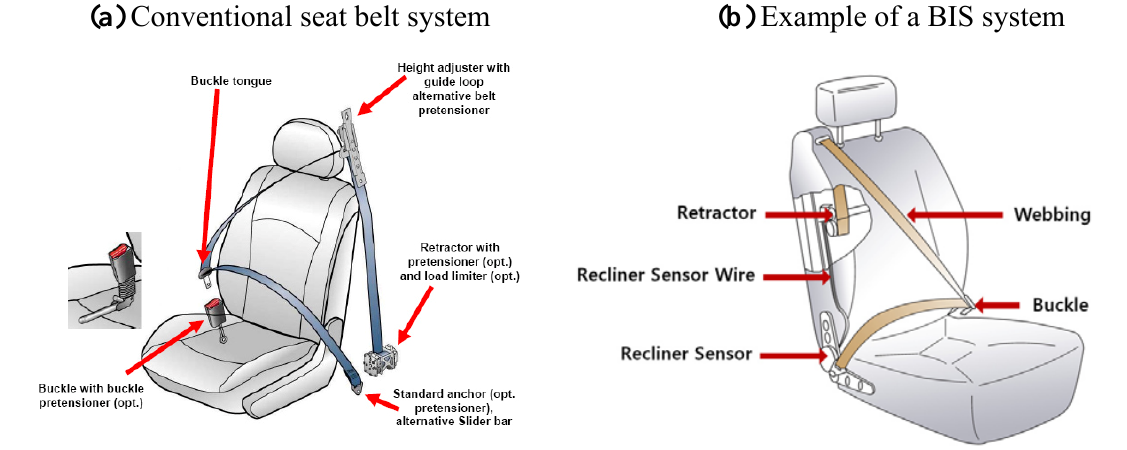
Figure 1. Conventional seat belt system and BIS system